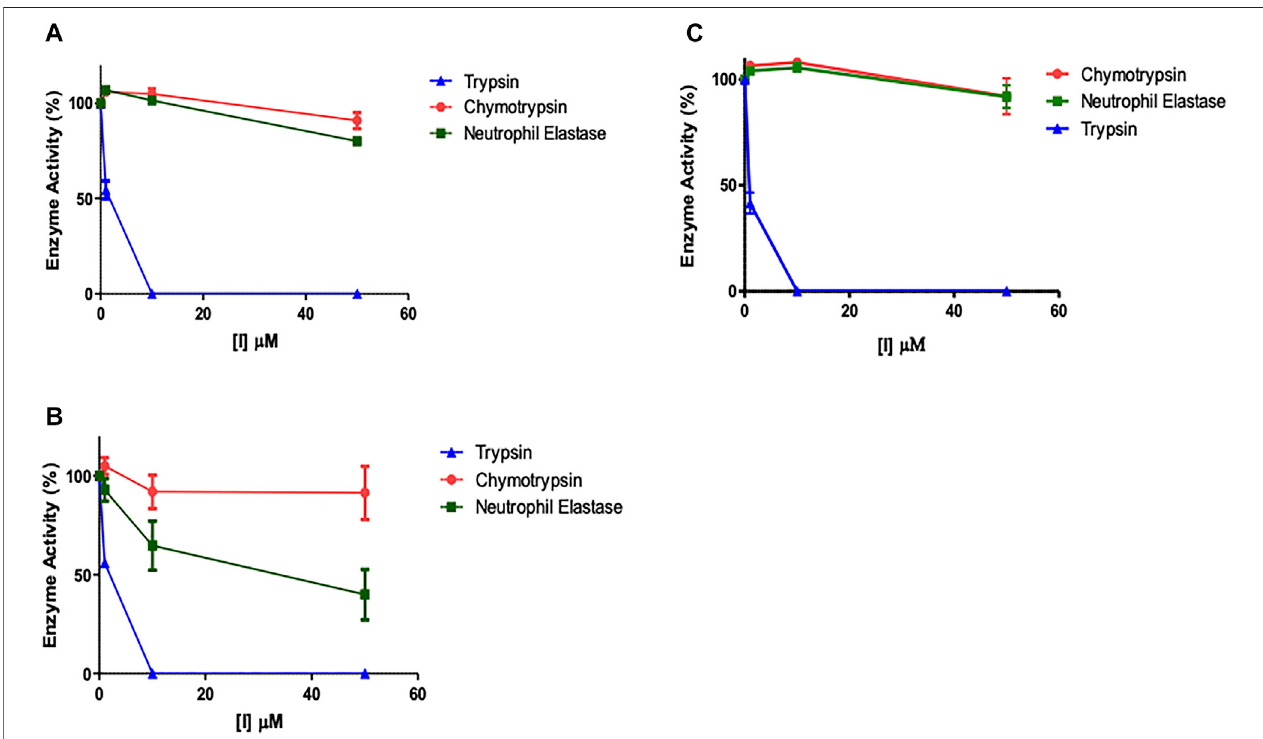
FIGURE8| Assessmentofpotential “ off-target ” inhibitoryeffectsofNArganaloguesversusaselectionofserineproteases.Theimpactof (A) NAP897, (B) NAP884 and (C) NAP858 activity ontrypsin,chymotrypsinand neutrophil elastase wasassessed using thecognate fl uorogenicsubstrates.Results shown asmean±SD( n =2).